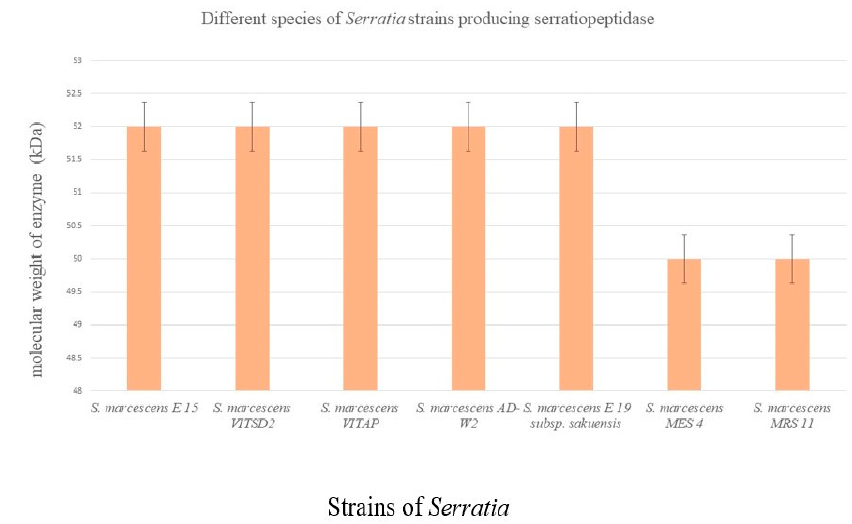
Figure 2. Molecular weight of serratiopeptidase produced from different strains of Serratia . Serratia marcescens E-15 [40], Serratia marcescens VITSD2 [48], Serratia marcescens VITAP [4], Serratia marcescens AD-W2 [44], Serratia marcescens subsp. sakuensis [32] Serratia marcescens MES 4 [46], Serratia marcescens MR 11 [46].